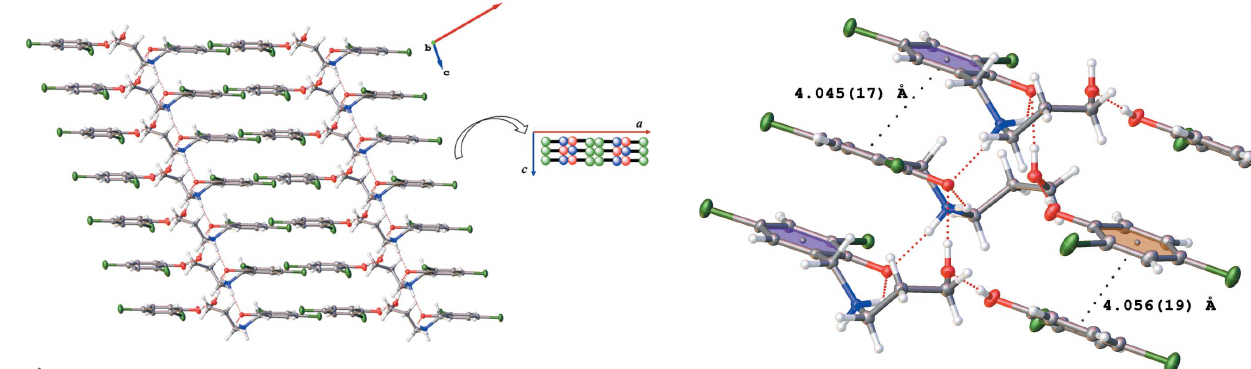
Figure 3 Packing diagram of the title compound viewed down the b axis, clearly showing the hydrogen-bonded polar channels and the 2,4-dichlorophenol hydrophobic